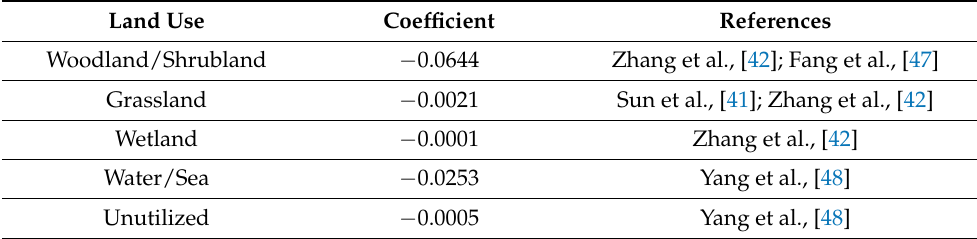
Table 1. CE coefficient of different land use types (kg · m − 2 · a − 1